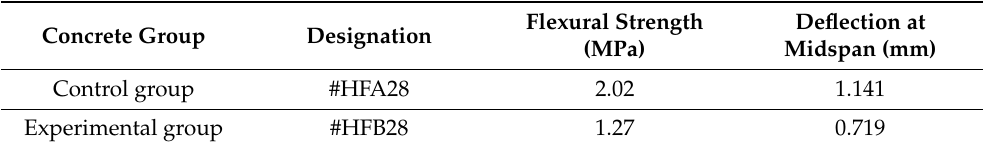
Table 24. Results of secondary flexural test of the flexural failure specimens exposed to high tempera- ture after self-healing.